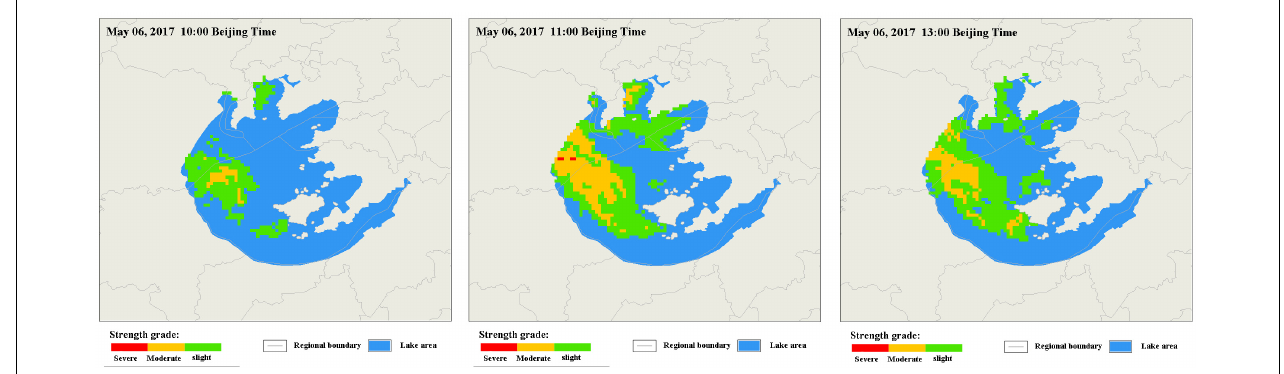
FIGURE 11 | Floating algae detection using Himawari/AHI data for Taihu Lake, China, on 6 May 2017 (10:00–13:00 Beijing